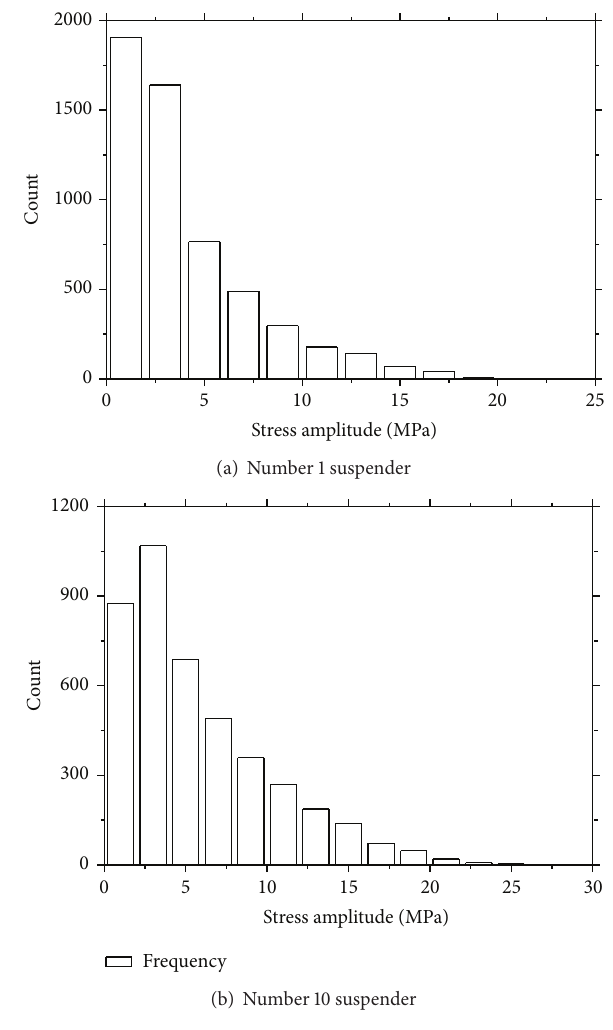
Figure 15: Statistical analysis of stress processes.